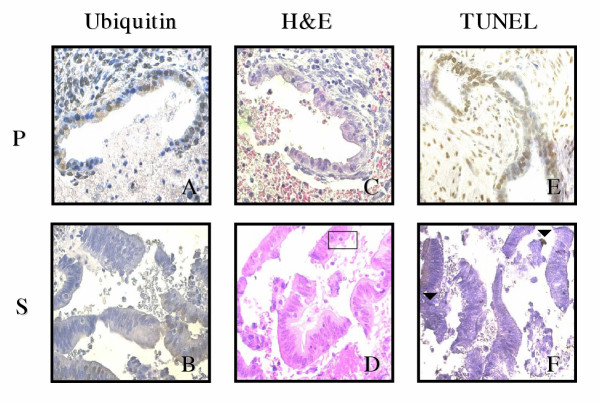
Immunohistochemical staining of endometriotic implants. Panels A and B are ubiquitin stained sections where brown cells are ubiquitin labelled (X400). Panels C and D are H&E stained sections where □ are apoptotic cells (X600). Panel E and F are TUNEL stained sections where ▼ are TUNEL positive cells. Menstrual cycle phases: P = proliferative and S = secretory.